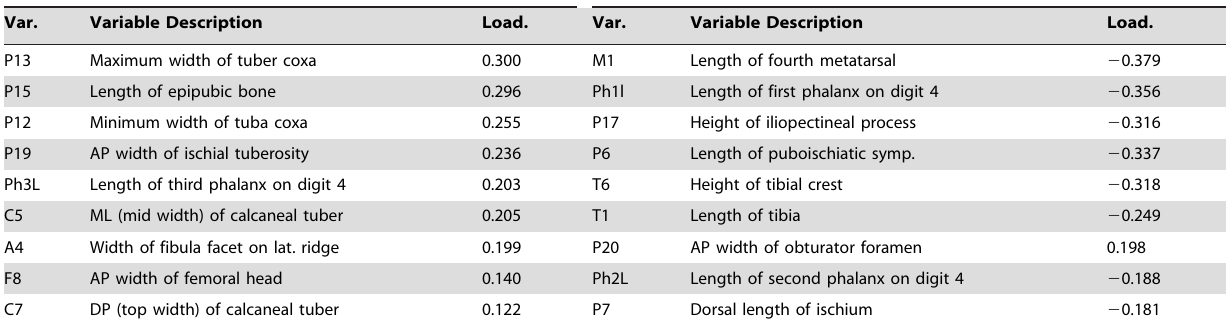
Loading Positively on the second component Loading negatively on the second